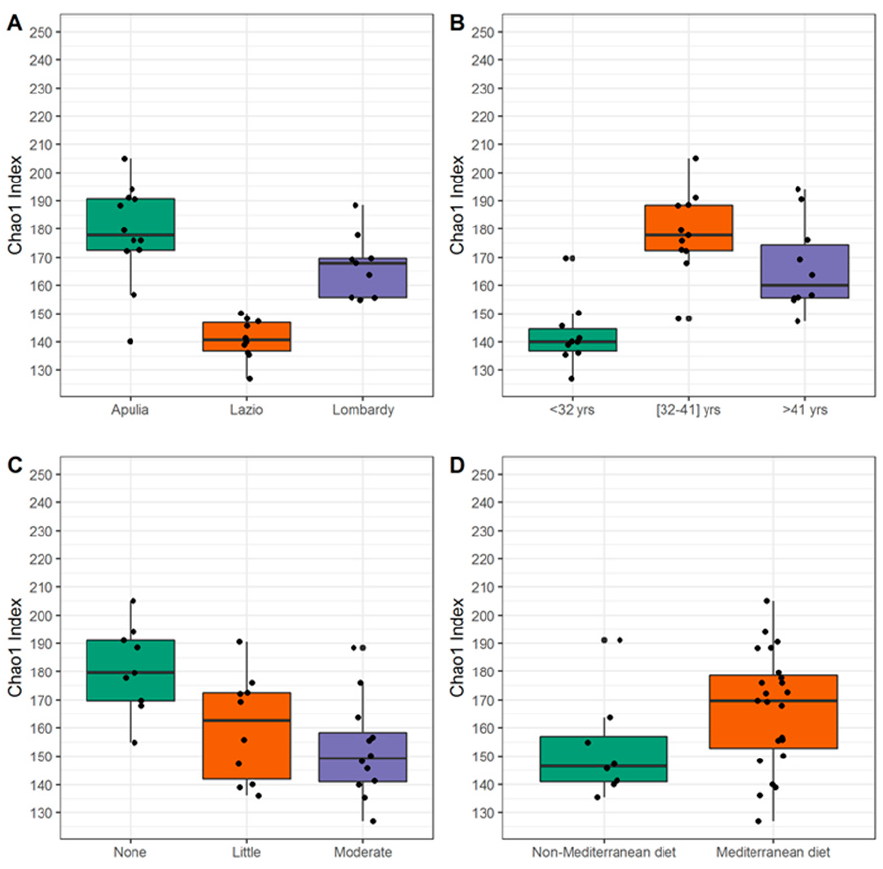
Figure 4. Box-plots of Chao1 index of species richness in Italian healthy subjects grouped by regions of origin ( a ), age classes ( b ), physical activity ( c ) and type of diet ( d ). Conversely, independently from the classification criterion, no statistically significant difference was found for the Shannon index, which takes into account the number and the relative abundance of the species within each sample (data not shown). Furthermore, as for beta-diversity, Kruskal’s non- metric MultiDimensional Scaling (MDS) plots of the Bray-Curtis dissimilarities did not reveal any significant clustering neither by regions (Figure 5a) and age classes (Figure 5b) nor by other classification criteria, as indicated by mean silhouette values around zero. The lack of Shannon index and beta diversity association may due to the sampling of multiple village sites and multiple cities within the study.